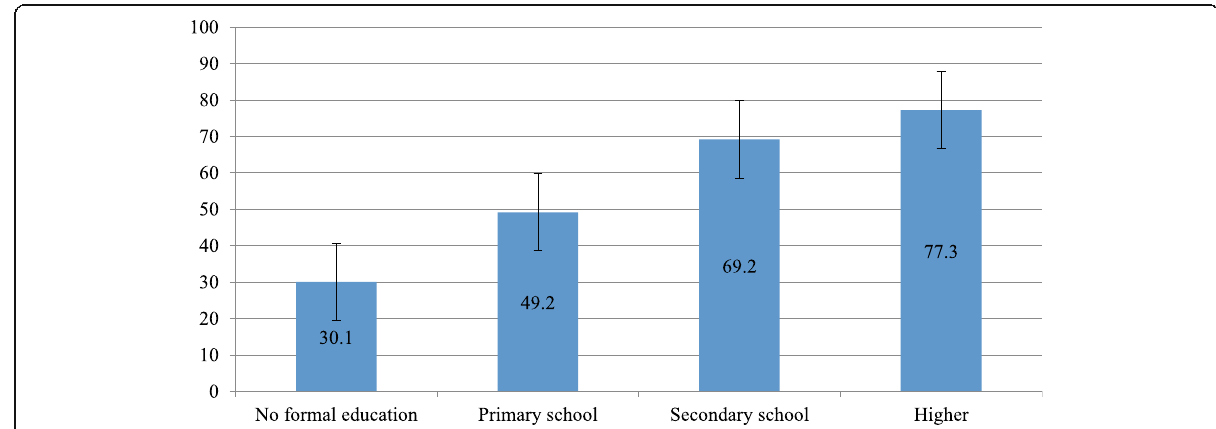
Fig. 2 Utilization of deworming medication among pregnant women based on educational level: evidence from 26 sub-Saharan African countries